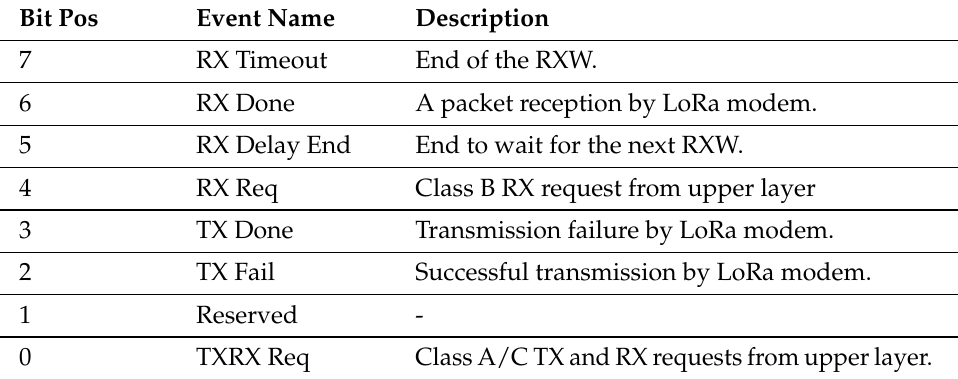
Table 5. Event bit